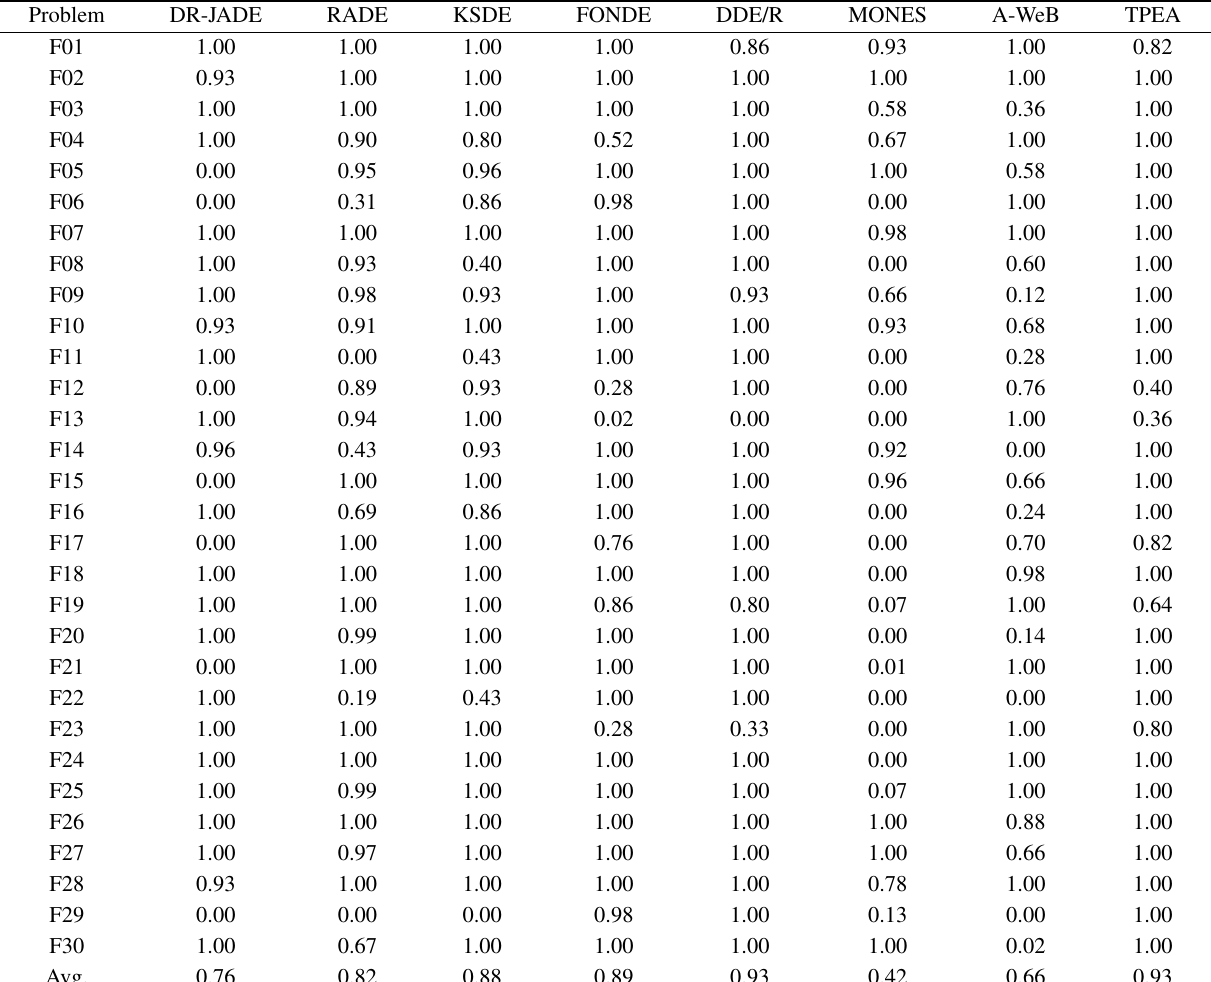
Table 4 Comparison of success rate with respect to different intelligent optimization